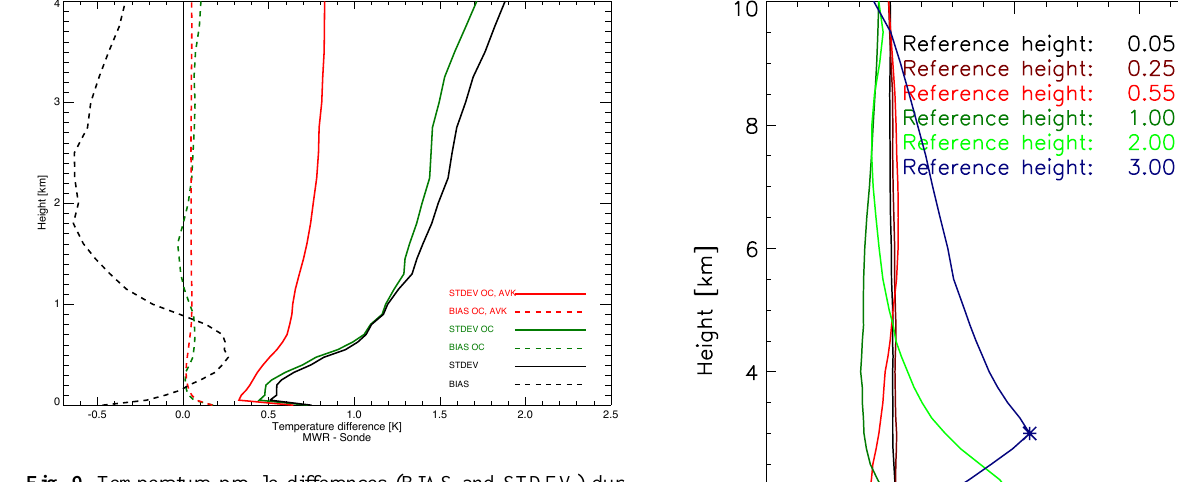
Fig. 9. Temperature profile differences (BIAS and STDEV) during all-sky conditions from August 2006–December 2009 between MWR and radiosonde measurements. The MWR retrieval coefficients were derived from the whole 1992–2009 radiosonde data set, whereas and the TB correction was derived only from clear-sky measurements as in Fig. 8. Black lines show the retrieval results without using the systematic TB offset correction while green lines show the results applying the systematic TB offset correction (OC). Additionally, in red the STDEV is shown after smoothing the radiosonde profile with the averaging kernel (AVK). A total number of 1816 matching MWR/radiosonde cases are evaluated in the plot.